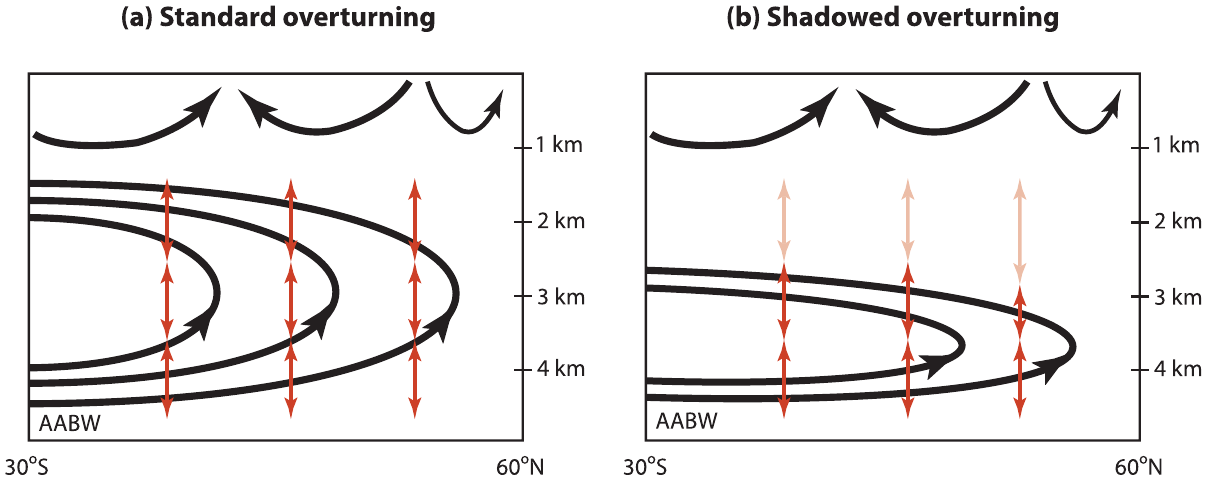
Fig. 1 Paradigms of the Paci fi c meridional overturning circulation (PMOC). Schematic of the PMOC as envisioned by the standard conveyor paradigm ( a ) and by the shadowed conveyor paradigm ( b ). PMOC streamlines are black and diapycnal diffusion is indicated by double-headed red arrows. The deep overturning cell carries Antarctic Bottom Water (AABW) northward. For the shadowed conveyor, the deep overturning is vertically compressed and separated from the mode/intermediate-water circulation of the upper ocean by a shadow zone characterized by relatively weak vertical mixing (light-red